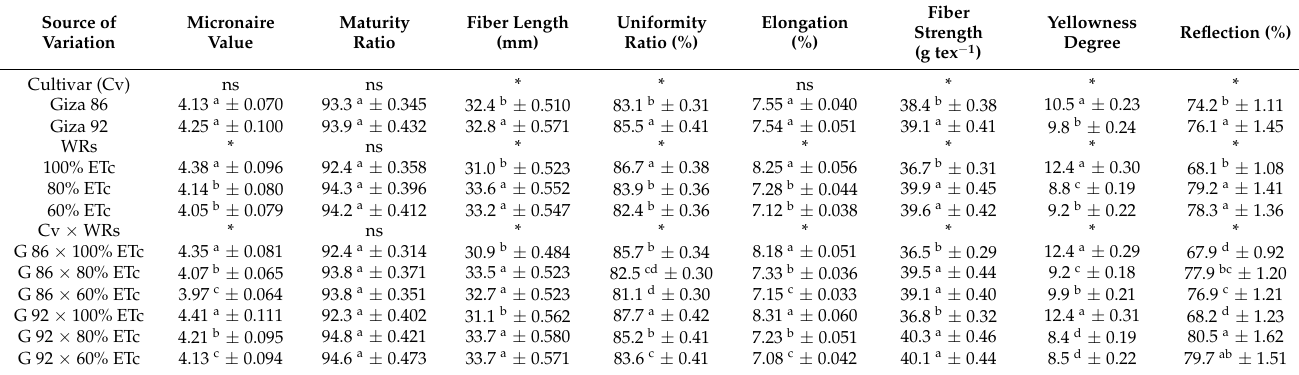
Table 5. Fiber quality properties of cotton (cv. Giza 86 and 92) under different water regimes (WRs) on sandy soil. All values are the average of the 2019 and 2020